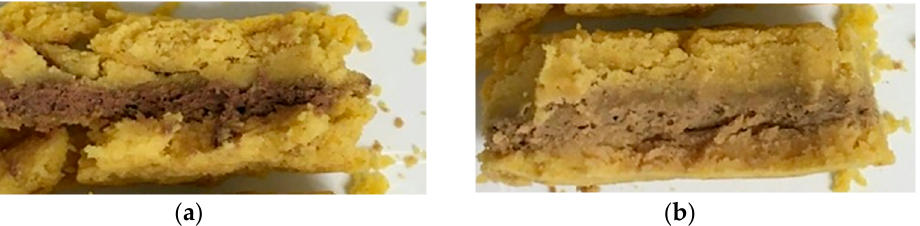
Figure 3. Photos of a longitudinal section of the 3D-printed food (form C) taken after 21 days in storage under ( a ) N 2 -MAP and ( b ) O 2